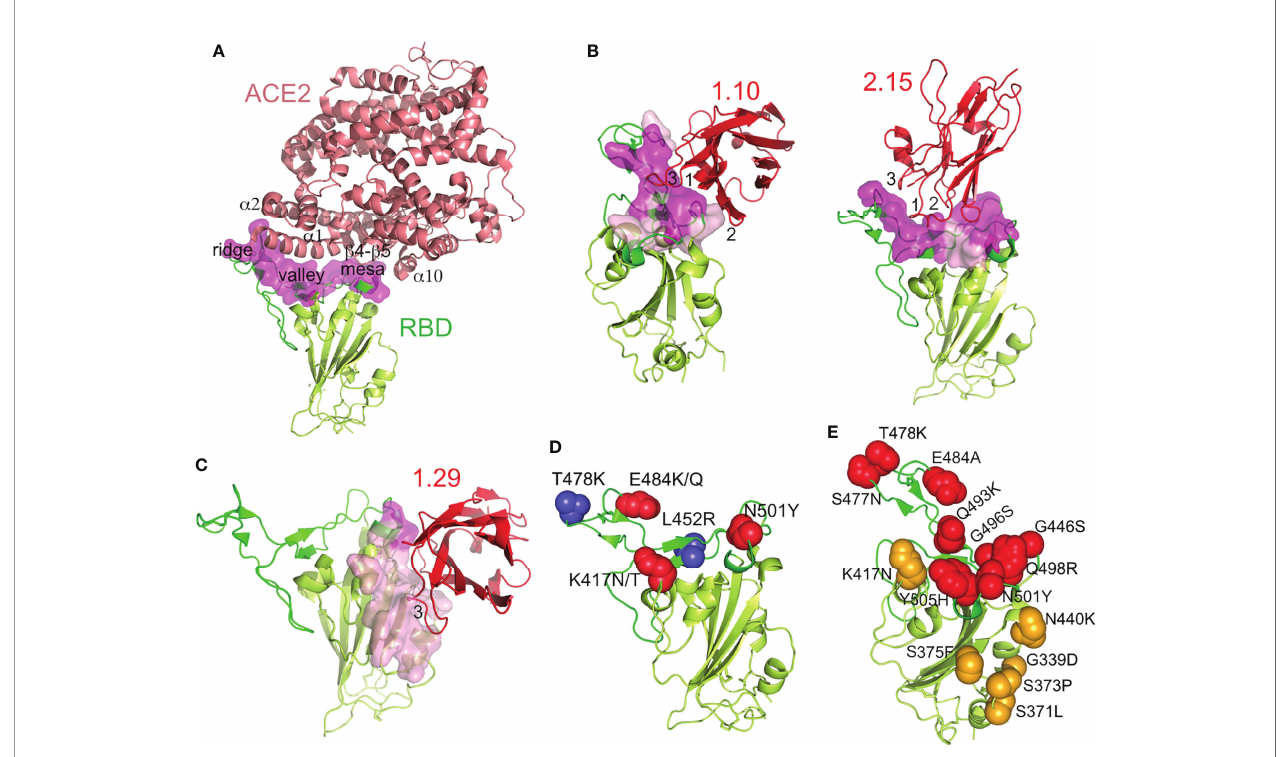
FIGURE 6 | Nb binding epitopes at the SARS-CoV-2 RBD, overlapping with the ACE2 receptor binding region and with mutations in the SARS-CoV-2 RBD variants. (A) The SARS-CoV-2 RBD-ACE2 complex structure. Ribbon representation of the RBD-ACE2 crystal structure (PDB id 6LZG), with ACE2 colored in salmon, the RBD with the RBM in green, the core in light-green and with its ACE2-binding residues as a surface in magenta. The ACE2 motifs that contact the indicated RBM regions labeled. (B, C) Structures of the SARS-CoV-2 neutralizing Nbs bound to the RBD. Ribbon representations of the RBD and the indicated bound Nb (red) with the CDRs (1, 2 and 3) that contacted the ligand labeled. Surface representations of the RBD residues at the interface with the Nbs are shown pink and with the residues that also engaged ACE2 in magenta, as in panel (A) . (D) RBD adaptation in SARS-CoV-2 variants of concern, except omicron. RBD residues that changed with respect to WA1 in the alpha (N501Y), beta (K417N, E484K, N501Y), delta (L452R, T478K), gamma (K417T, E484K, N501Y) and kappa (L452R, E484Q) variants are shown as red or blue spheres. (E) RBD evolution in the SARS-CoV-2 omicron variant. Side chains of RBD residues altered with respect to WA1 in the RBM or RBD core are shown as red or orange spheres, respectively. Residue substitutions are